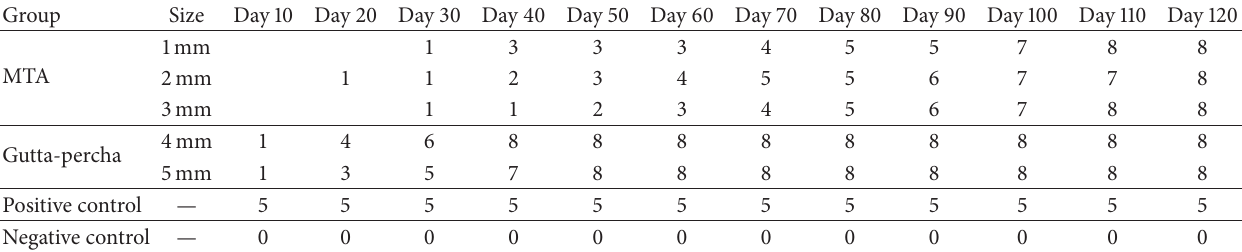
Table 1: The number of samples with microleakage in each group during the evaluation period. Group